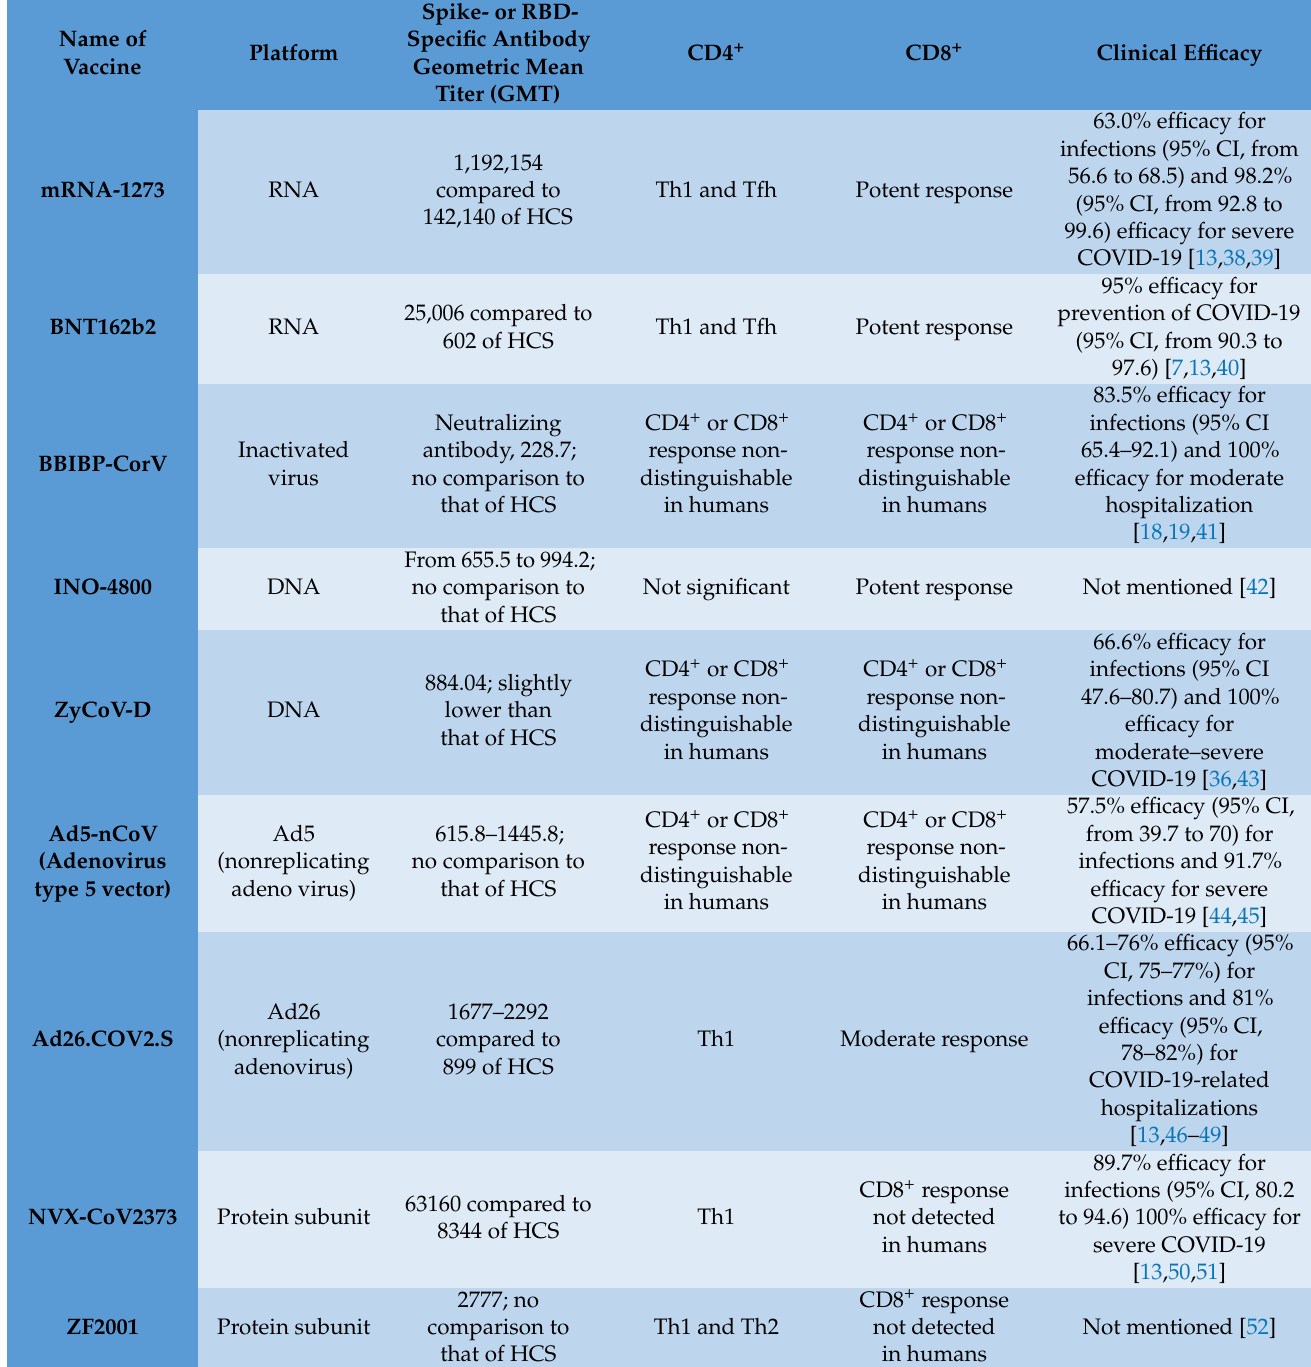
Table 1. The immune characteristics and protection efficiency of the different platform-based vaccines (HCS, healthy convalescent